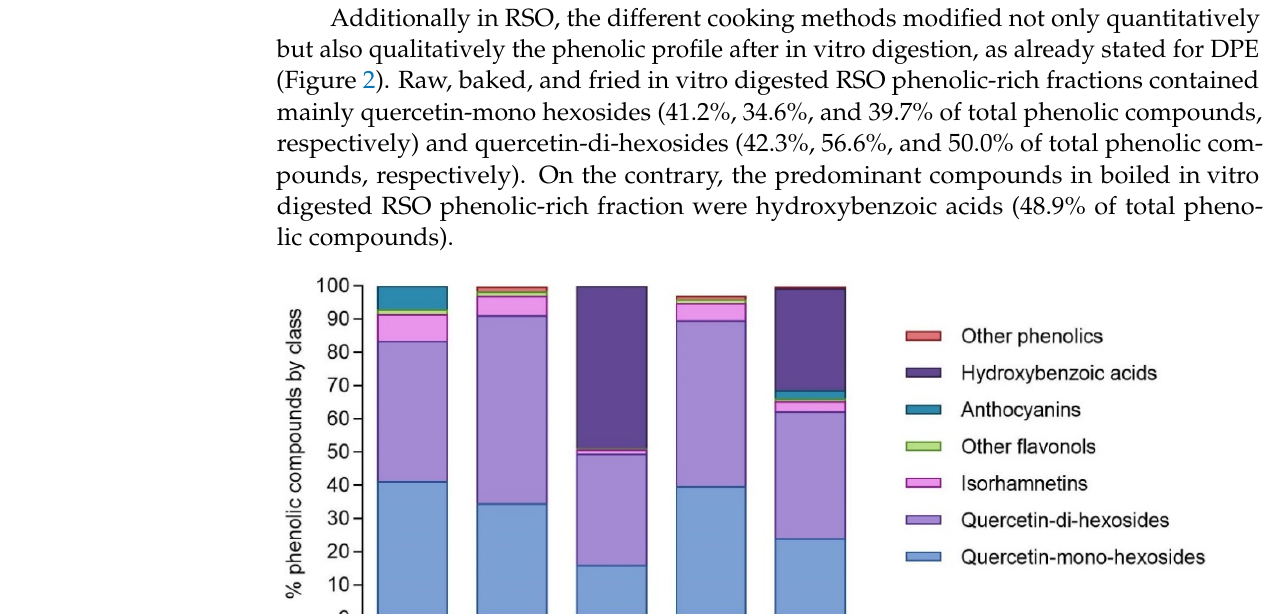
Different letters within the same row mean significant different (p < 0.05) values. n.d. means that the compound was not detected in the sample.